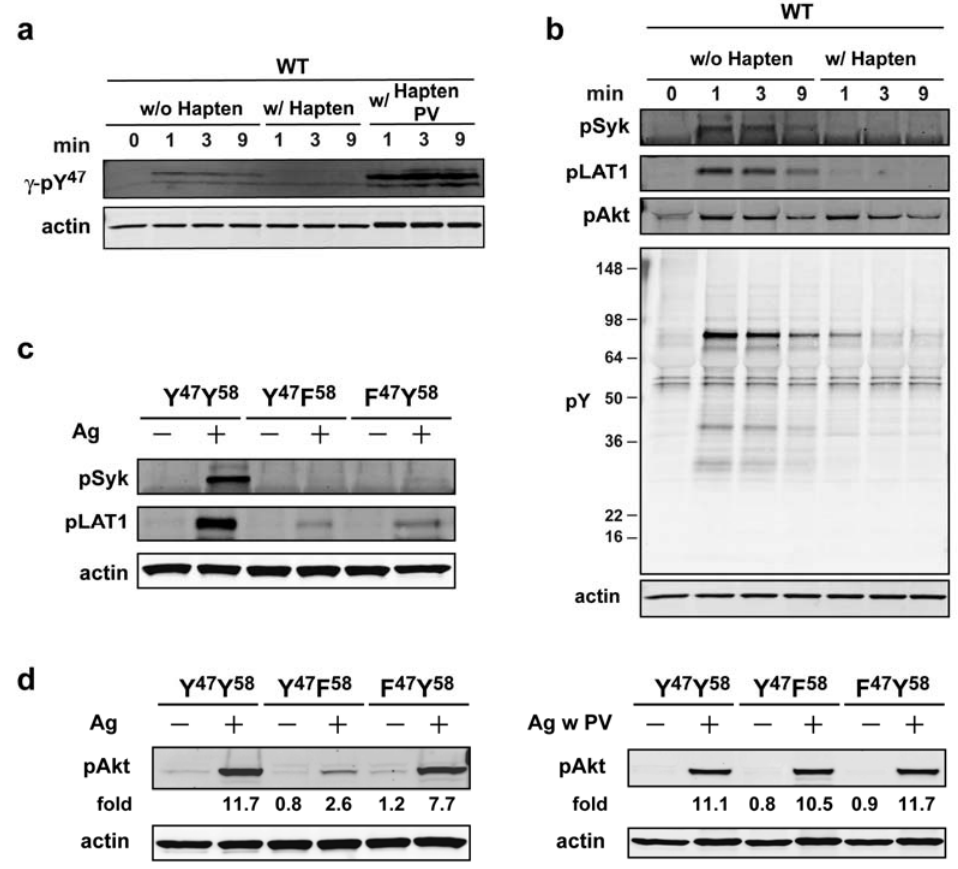
Figure 4. Akt phosphorylation is largely initiated by Fc ε RI γ ITAM Y 58 butonce phosphorylated it does not require persistent Fc ε RI aggregation. ( a ) WT cells were sensitized with IgE and stimulated with Ag. At 30 s of Ag addition hapten (DNP-L-Lys, 100 µM) was added in the presence or absence of pervanadate (PV: 1 mM) and cells were incubated for the indicated time. Whole cell lysates were resolved and immunoblotted with γ -pY 47 antibody. ( b ) Effects of Fc ε RI disaggregation on proximal signaling proteins as analyzed using indicated antibodies. ( c ) IgE-sensitized BMMCs expressing WT (YY) or mutated (YF, FY) Fc ε RI γ were stimulated for 1 min with Ag. Whole cell lysate proteins were resolved by SDS-PAGE and immunoblotted with indicated antibodies. ( d ) BMMCs expressing WT or mutant Fc ε RI γ were sensitized with IgE and were either not stimulated or stimulated with Ag in the presence or absence of pervanadate (PV: 1mM). Proteins in whole cell lysates were resolved and immunobloted with phospho-specific (T 308 ) Akt